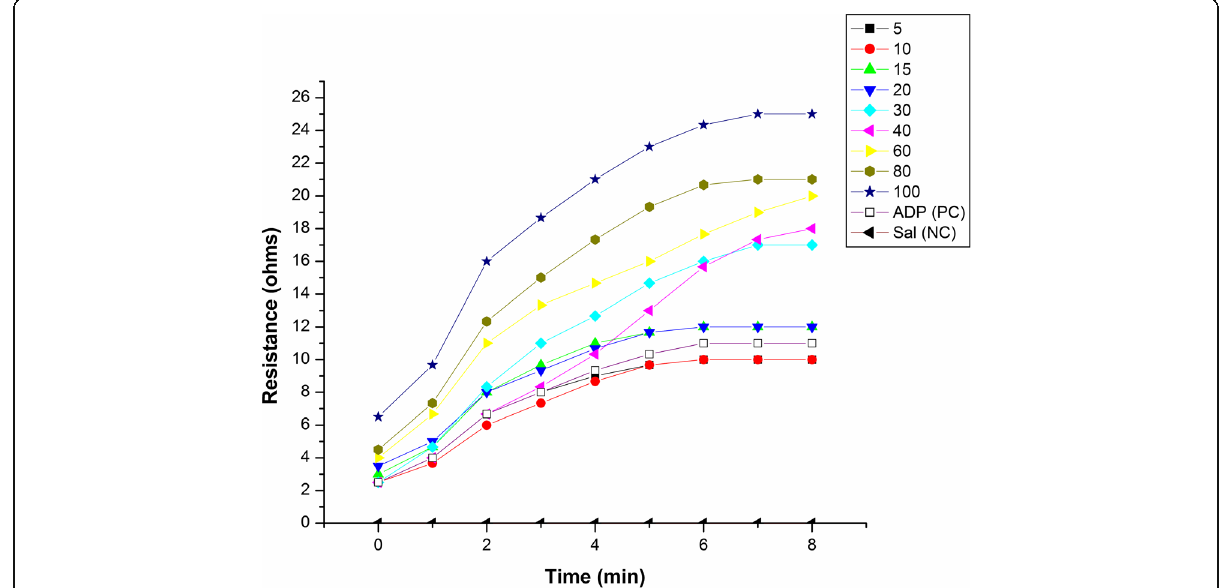
Fig. 8 Effect of SCF on ADP-induced platelet aggregation. Blood was treated with different dosages of SCF and platelet aggregation was induced by ADP and measured using whole blood platelet aggregometer. PC = Blood incubated with saline and ADP; NC = Blood incubated with saline only (no agonist added). SCF inhibited platelet aggregation till a dosage of 10 μ g/ml and promoted aggregation at higher dosages in a dose- dependent manner ( n = 3